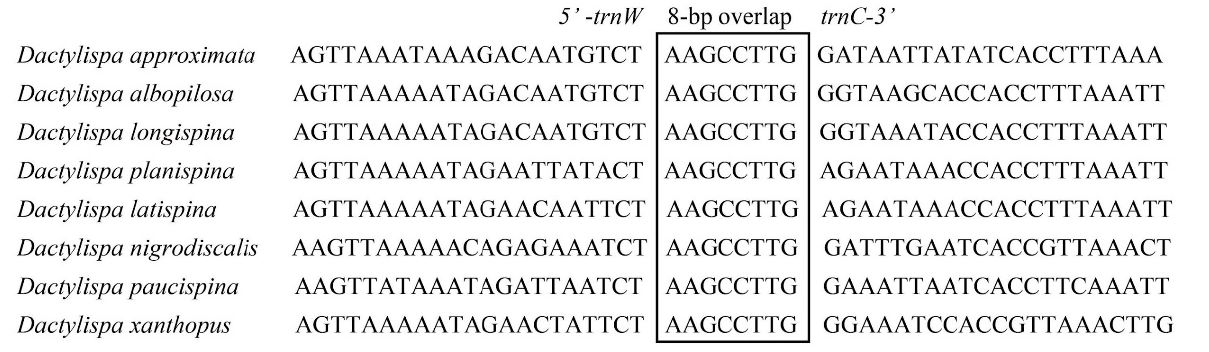
Figure 4. Sequence alignments of trnW/trnC of eight Dactylispa beetles. The boxed nucleotides are the eight ‐ base pair conserved overlaps.